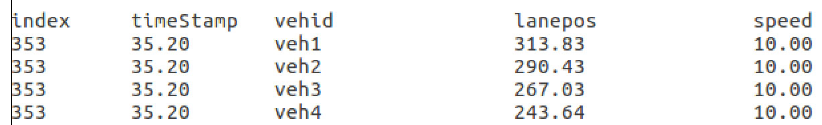
Fig. 4. Scenario 4: Part of the Output Log Shows that Vehicle Speed is 10